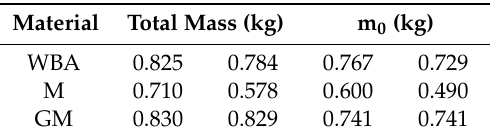
Table 4. Data required in the percolation column